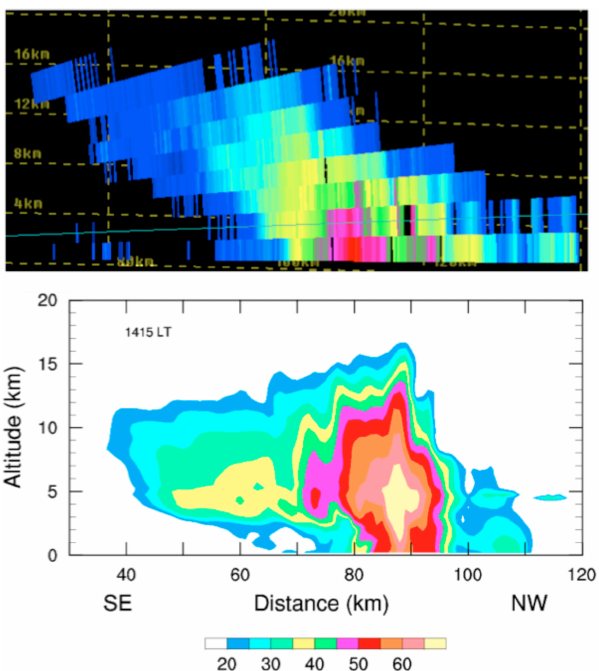
Fig. 8. Vertical cross section comparison of observed radar reflec- tivity at 16:00LT (top, from Vaughan et al., 2008) to modeled re- flectivity at 14:15LT (bottom). The radar echo density (dBZ) is con- toured in both vertical cross sections. Note that the observed radar reflectivity follows the same dBZ scaling as Fig. 7